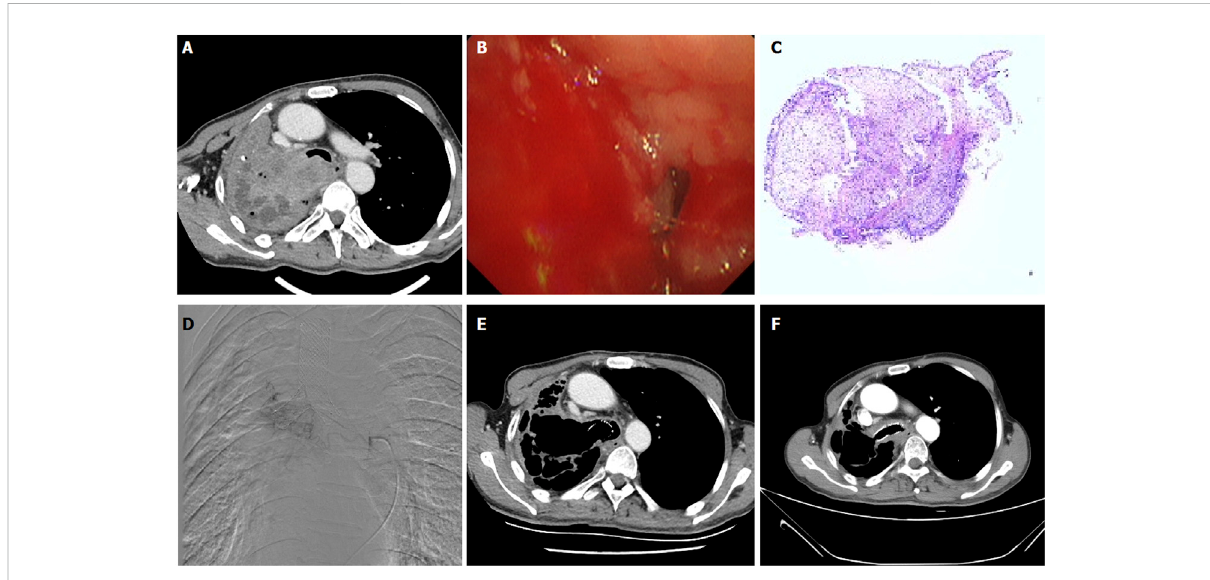
FIGURE 2 A 65-years male treated by CalliSpheres beads for advanced squamous cell carcinoma. (A) Computed tomography examination on admission revealed malignant tumor, severe bronchial stenosis and complete atelectasis of right lung. (B) Fibrobronchoscopy revealed a right main bronchial occlusion. (C) Pathologicaldiagnosisofsquamouscellcarcinomabybiopsyofthelesion. (D) Therightbronchialarterywasthebloodsupplyarteryof the tumor, and was embolized by drug-loaded beads. (E) The right lung tumor was found to shrink after 1.5 months ’ follow-up. (F) The airway stent was in good position and the tumor was almost disappeared after 1